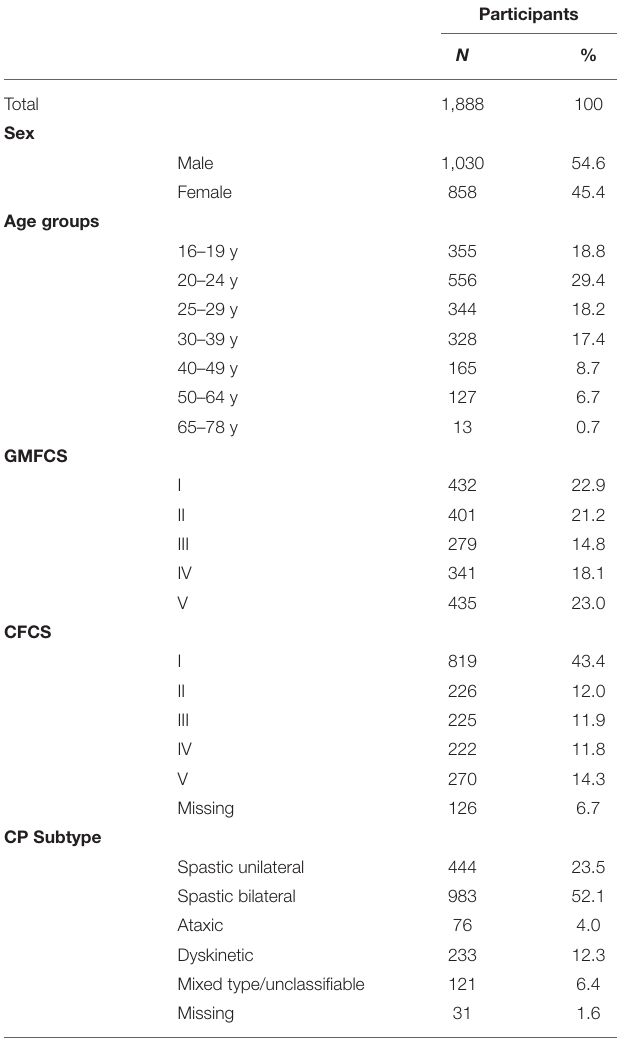
TABLE 1 | Characteristics of the 1,888 adults with